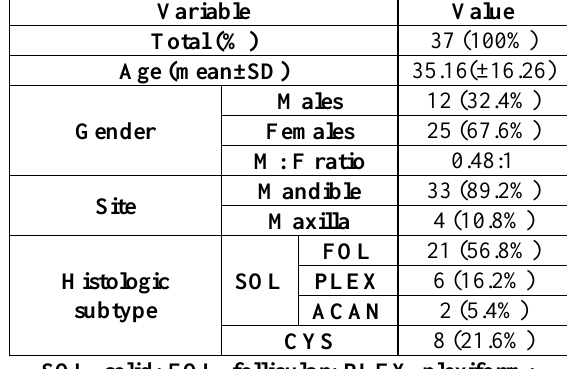
Table 1: Study sample characteristics